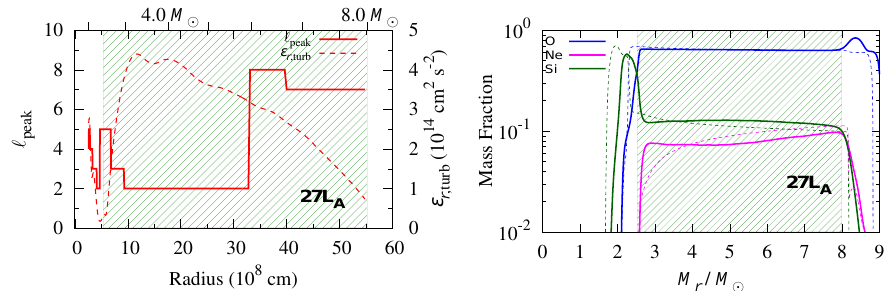
Figure 1. Left panel: The radial profiles of the peak mode ℓ peak obtained by the spectrum analysis of the radial turbulent velocity (solid curve) and the radial turbulent kinetic energy (dashed curve) of the 27 M ⊙ star. Right panel: the radial profiles of the oxygen (blue), neon (green), and silicon (magenta) mass fractions. Solid and dashed curves correspond to the last and initial profiles of the 3D